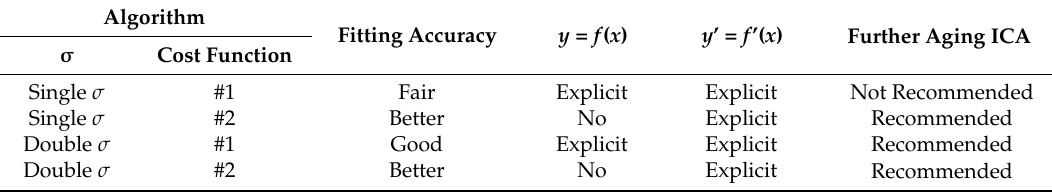
Table 2. Comparison of the SVR algorithms with different parametric settings.